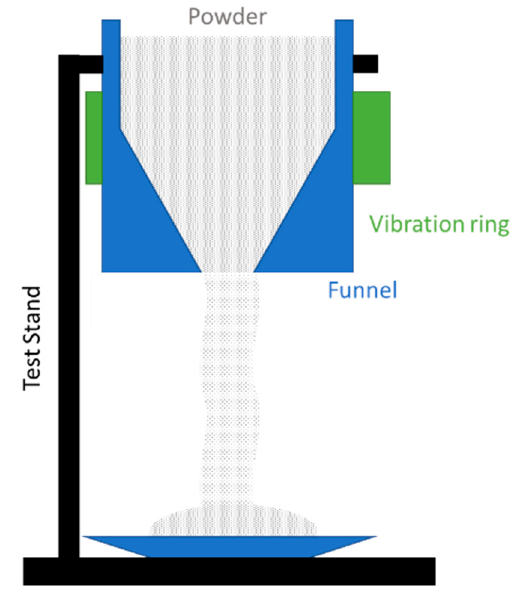
Figure 9. Schematic showing cross section of vibrational flowability test.